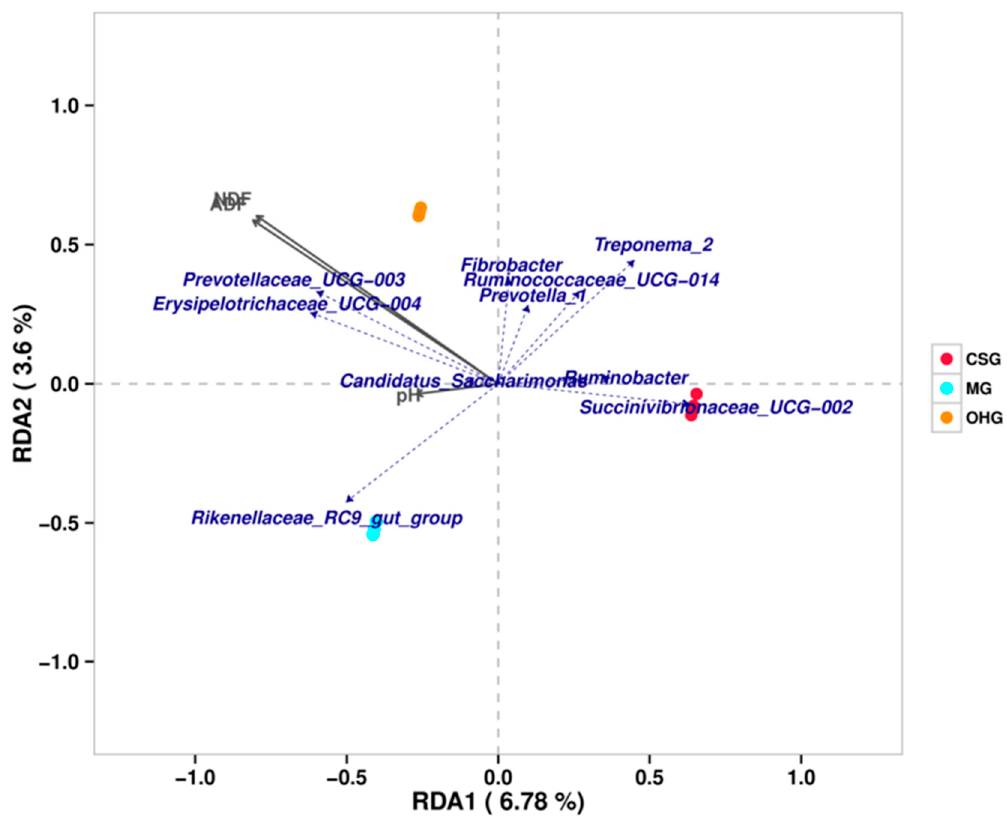
Figure 8. Bi-plot from the redundancy analysis (RDA) that shows the relationships between the bacterial community composition at the genus level and the environmental variables for all